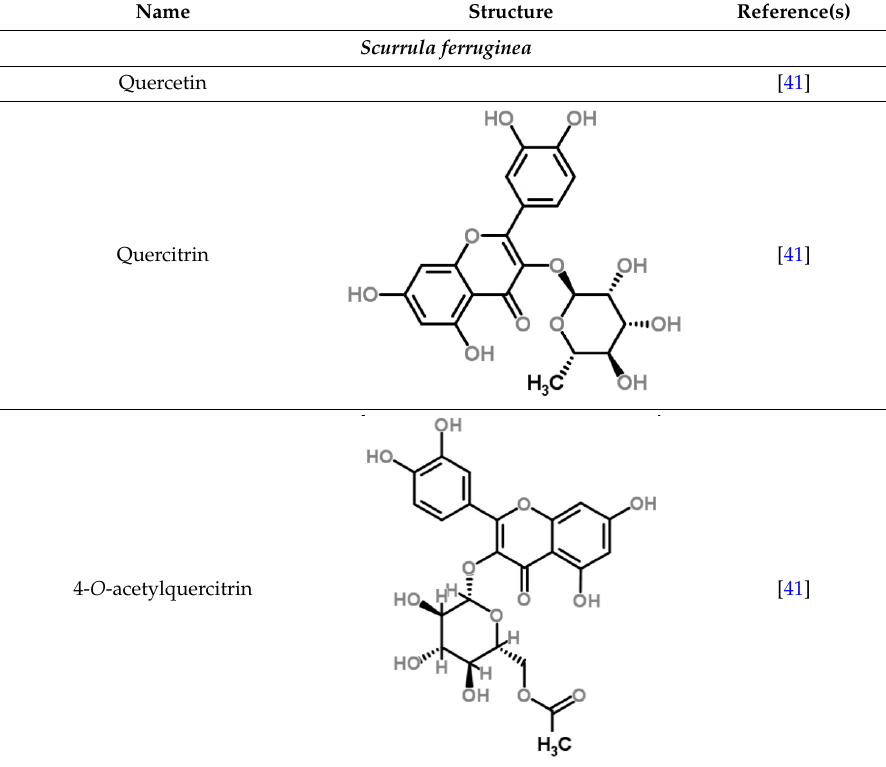
Table 3. Chemical structures of compounds found in Scurrula plants.